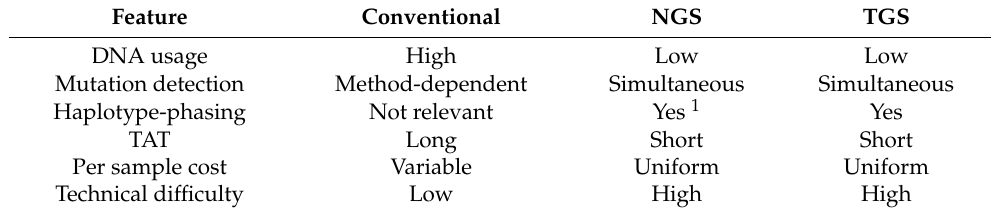
Table 2. Comparison of DNA analysis of thalassemia using the conventional method, NGS, and TGS. Feature Conventional NGS TGS DNA usage High Low Low Mutation detection Method-dependent Simultaneous Simultaneous Haplotype-phasing Not relevant Yes 1 Yes TAT Long Short Short Per sample cost Variable Uniform Uniform Technical difficulty Low High